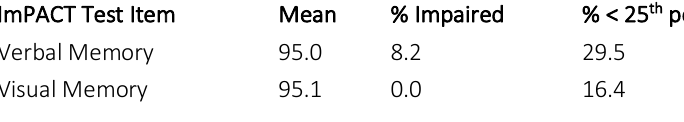
ImPACT Test Item